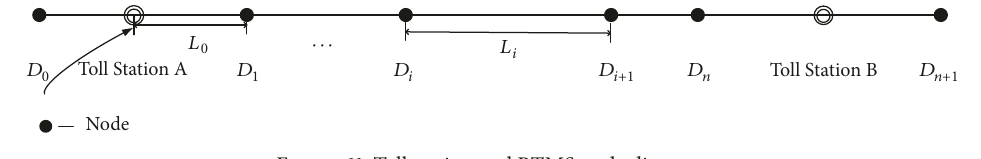
Figure 11: Toll station and RTMS node diagram.